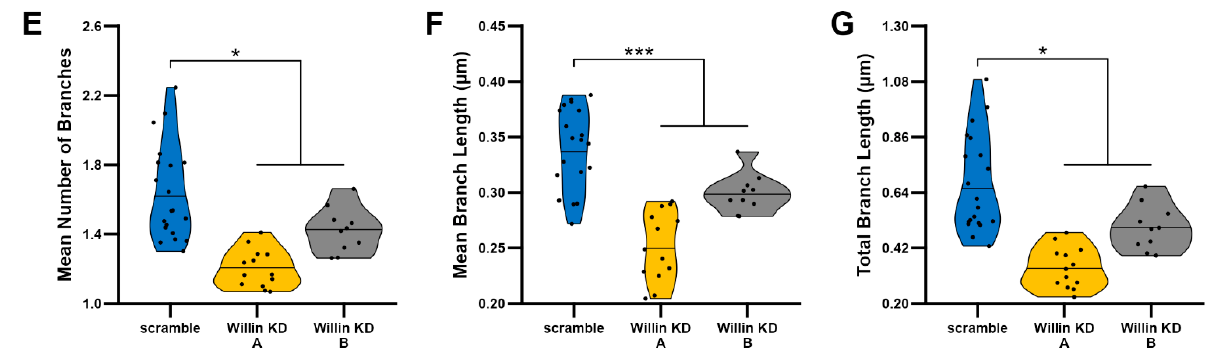
Figure 3. Willin/FRMD6 knockdown leads to mitochondrial fragmentation. Mitochondrial morphological and network abnormalities in Willin KD cells. HT-22 cells were labeled with TMRM for visualization of mitochondria morphology. ( A ) Representative images of TMRM staining. Scale bar = 10 μ m. ( B – G ) Quantitative measurement of mitochondrial morphological ( B – D ) and network parameters ( E – G ) using MitoSegNet for segmentation and analysis. n = 10-20 fields of view (FOV) per condition with 10-50 cells per FOV. Dots represent means per FOV. * p < 0.05. ** p < 0.01. *** p < 0.001.